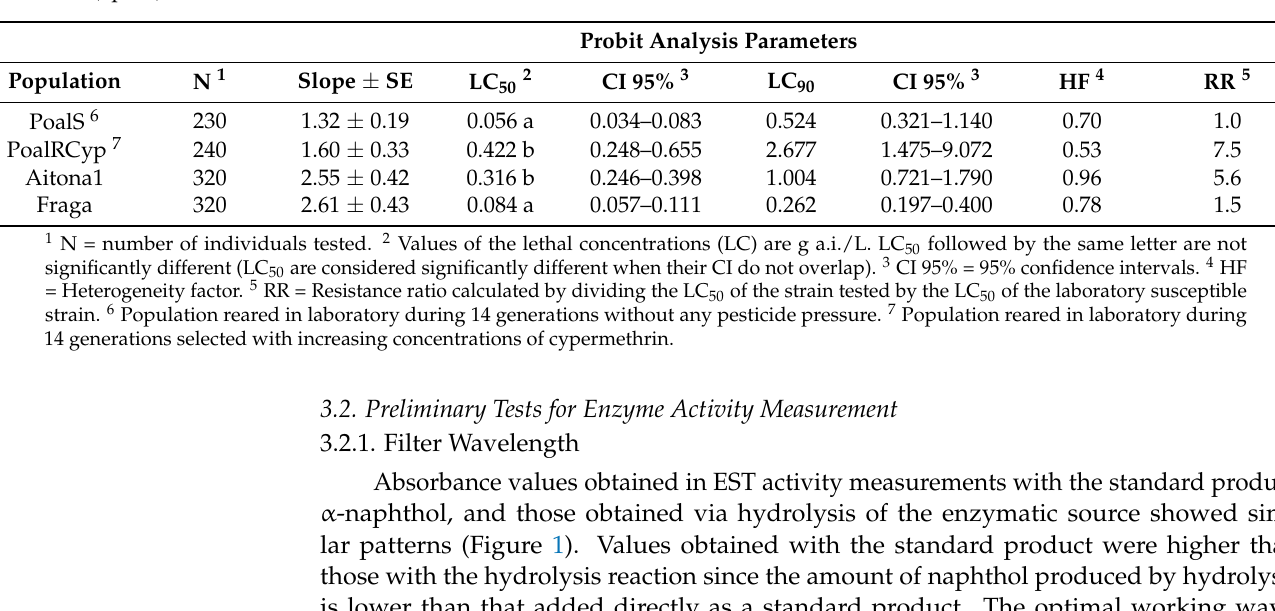
Table 1. Probit analysis results and resistance ratios to cypermethrin obtained after topical applications on adults of Cacopsylla pyri obtained from two reared laboratory strains and from two field populations collected in the Ebro Valley area